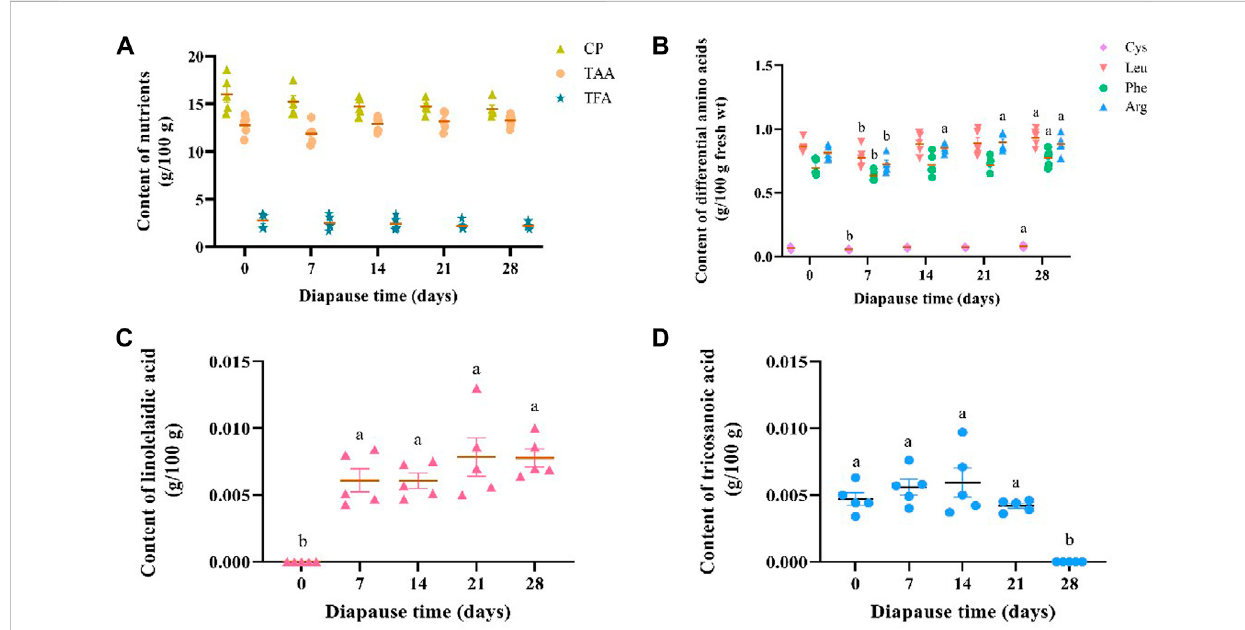
FIGURE 2 Effect ofdiapause time onthecontent ofcrude protein(CP),totalaminoacids(TAA),and totalfattyacids (TFA) (A) ,thecontent ofdifferentialamimo acids (including cysteine (Cys), leucine (Leu), phenylalanine (Phe) and arginine (Arg)) (B) , and diffrential fatty acids (including linolelaidic acid (C) and tricosanoicacid) (D) in C.bilineatatsingtauica larvae.Dataaremean±SEM.Differentlowercaselettersdenotesigni fi cantdifferenceamongdiapausetime by Tukey test at p <